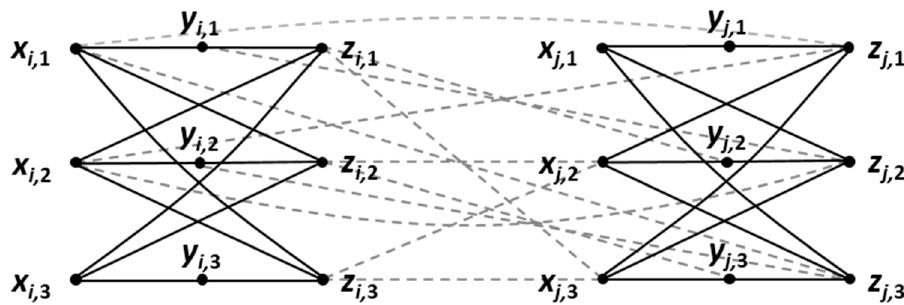
Figure 4. Subgraph connections where l i ,2 = l j ,3 . Dashed lines denote added edges.